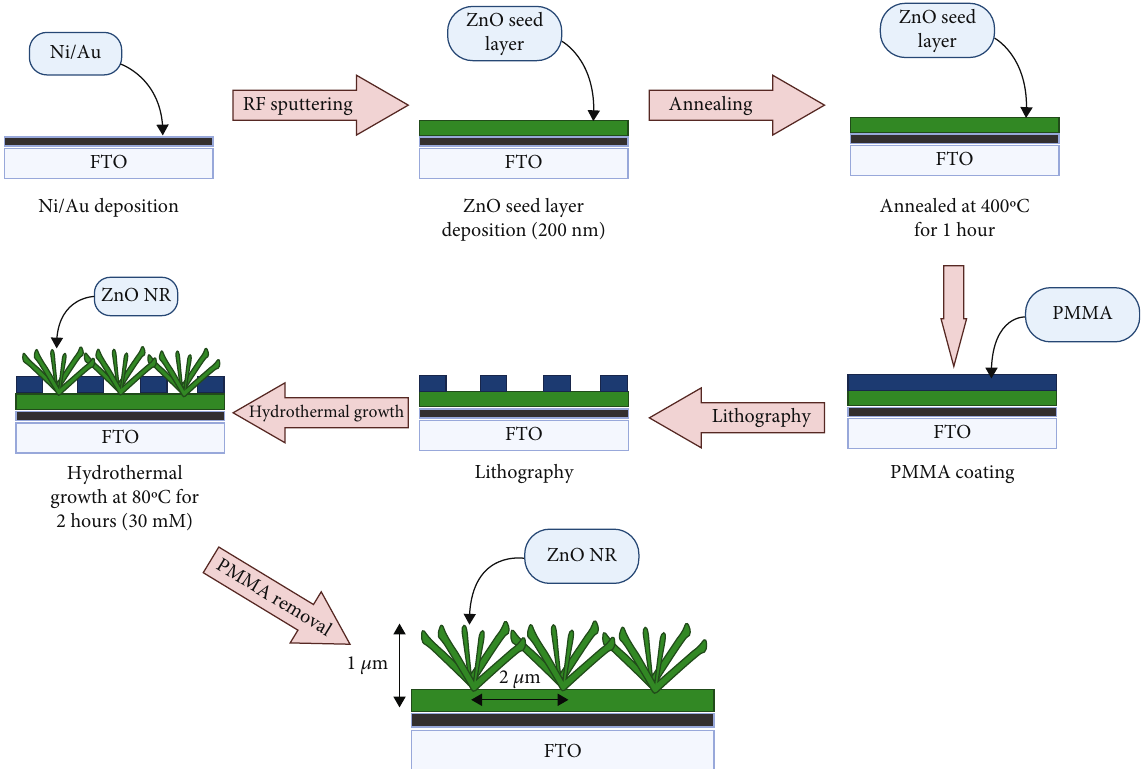
Figure 1: Schematics of inorganic ZnO nanorod layer preparation by combined lithography and hydrothermal